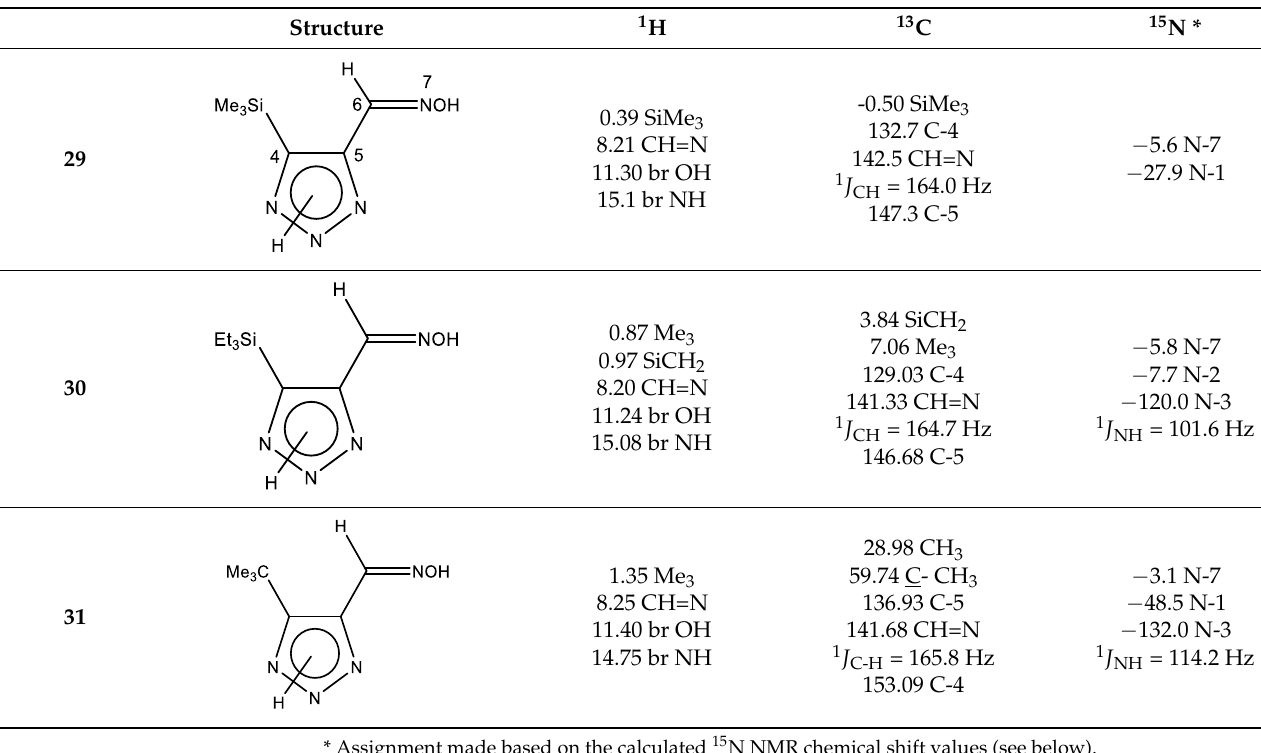
Table 4. 1 H, 13 C and 15 N NMR chemical shifts of 4-substituted 1,2,3-triazole-5-carbaldehyde oxime ( 29 , 30 , 31 ) (ppm, DMSO- d 6 ). Structure